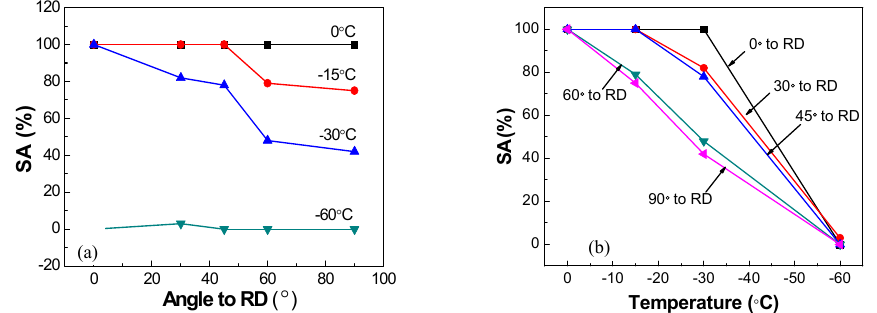
Figure 7. DWTT results: ( a ) curve between SA% (percent shear area) and directions, ( b ) curve between SA% and temperature.